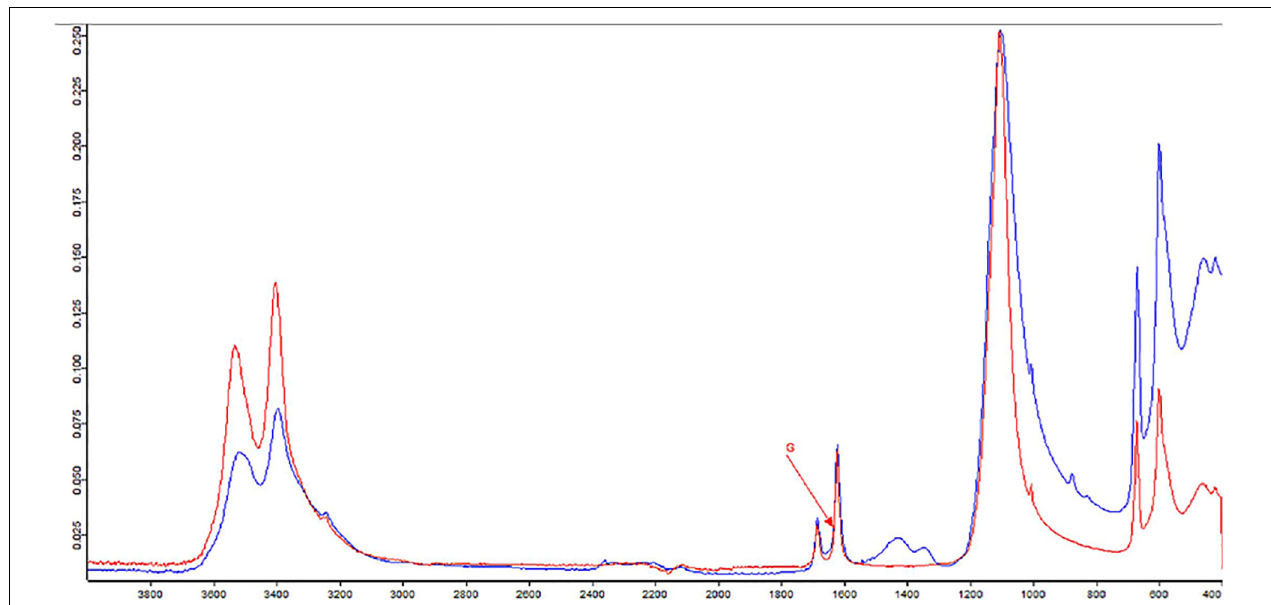
FIGURE 4 | Fourier-transform infrared spectroscopy (FTIR) spectra of sample from hypogeum in blue; in red, the reference (G =